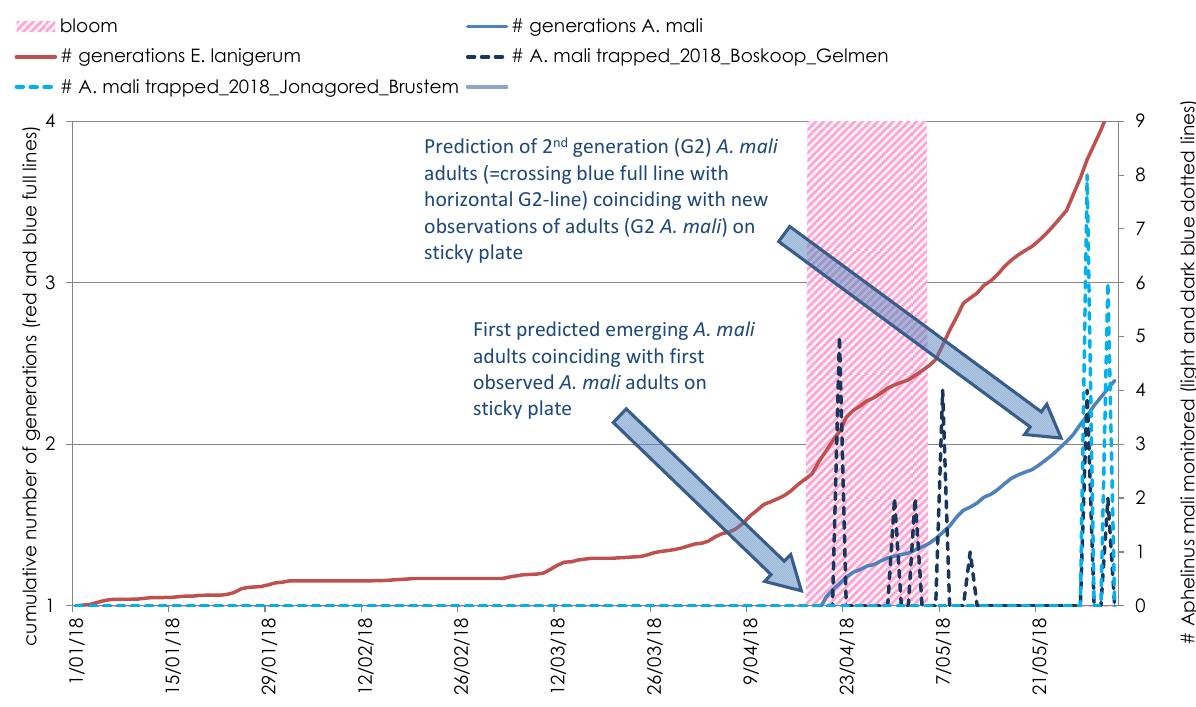
Figure 1. The development of E. lanigerum and A. mali as predicted (red and blue line, respectively) and as monitored A. mali adults at sticky plates (dotted lines) in the orchard at two different locations in the region of Sint-Truiden (apple cultivar Jonagored in Brustem and apple cultivar Boskoop in Gelmen) in 2018. Table 1. Predicted and observed dates of new first-generation (G1) A. mali adults (=start of the A. mali flights in the season) and second-generation (G2) A. mali